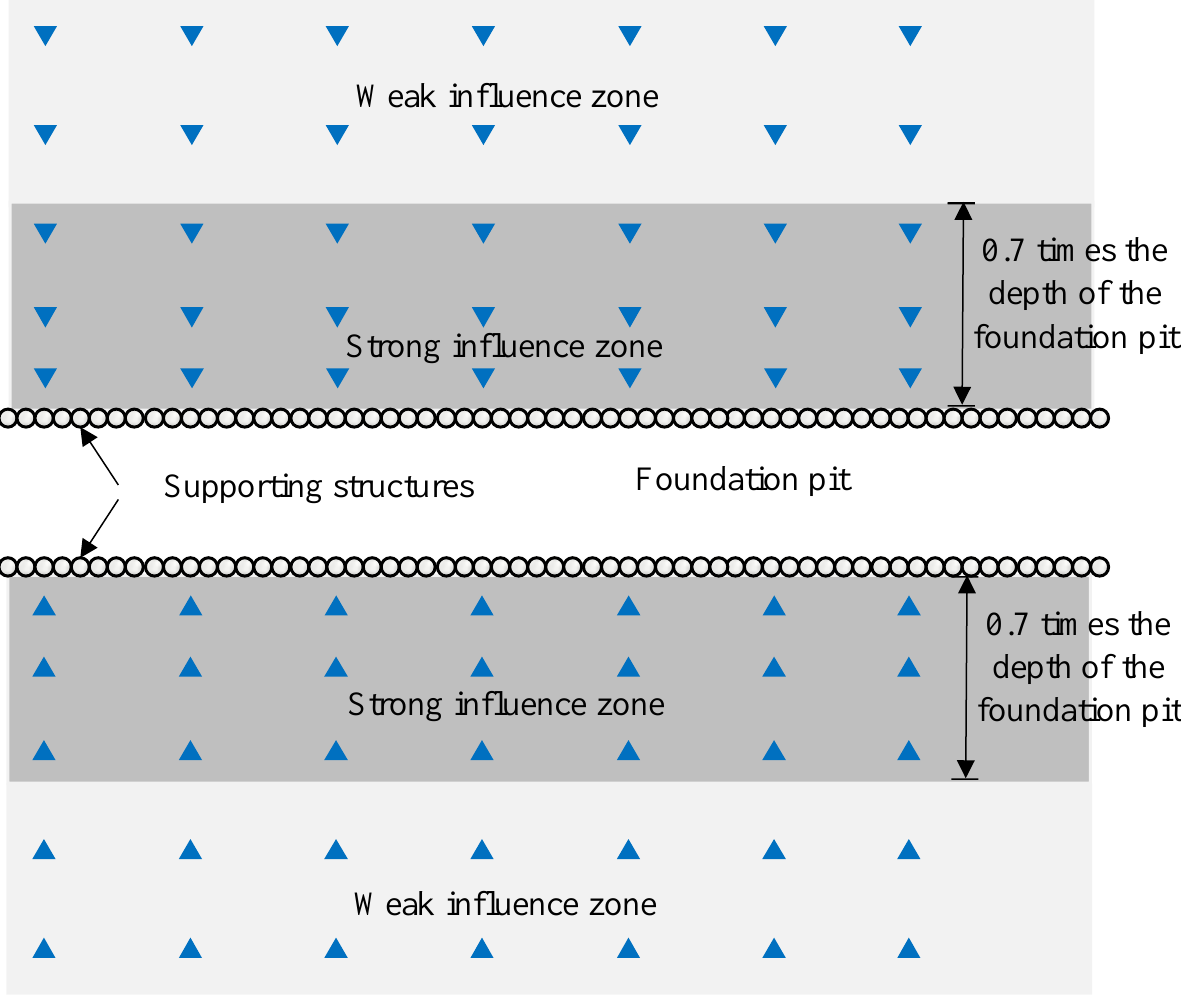
Figure 10. Diagram of the strong influence zone and the weak influence zone.